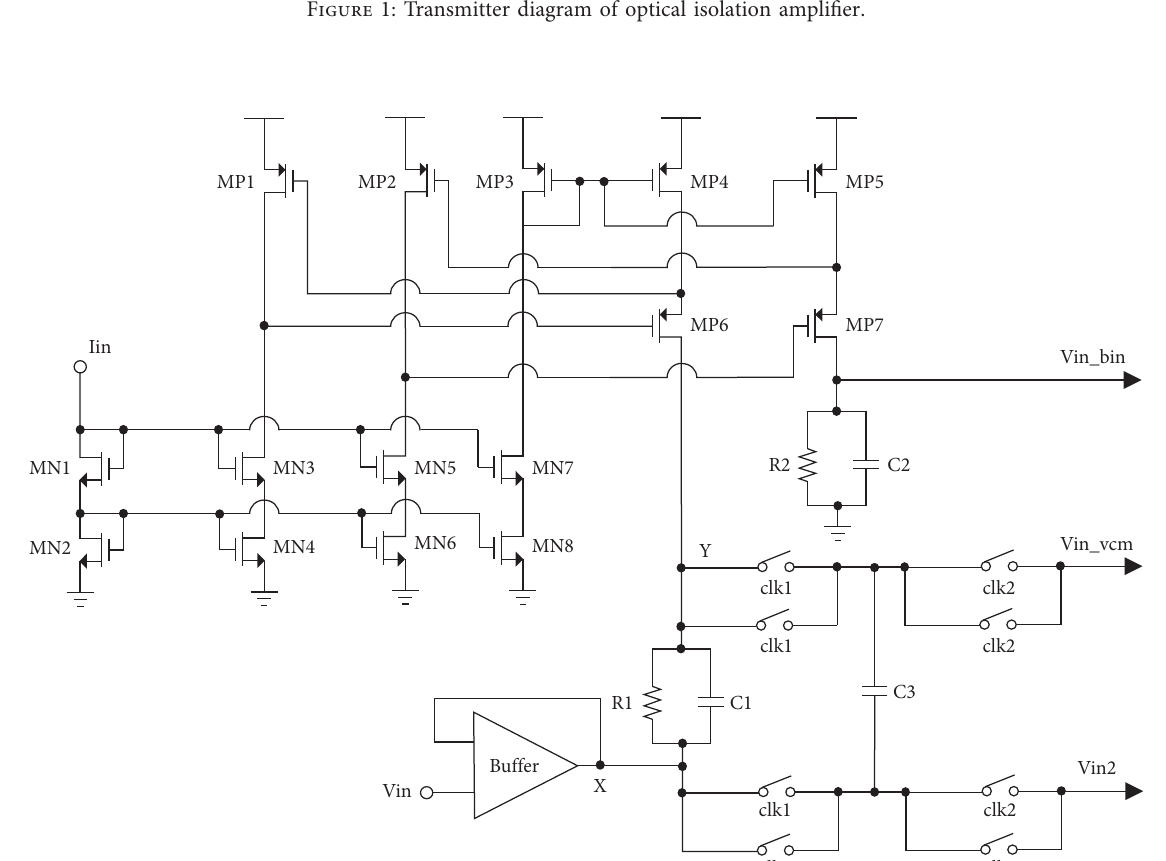
Figure 2: Built-in common-mode voltage generator.